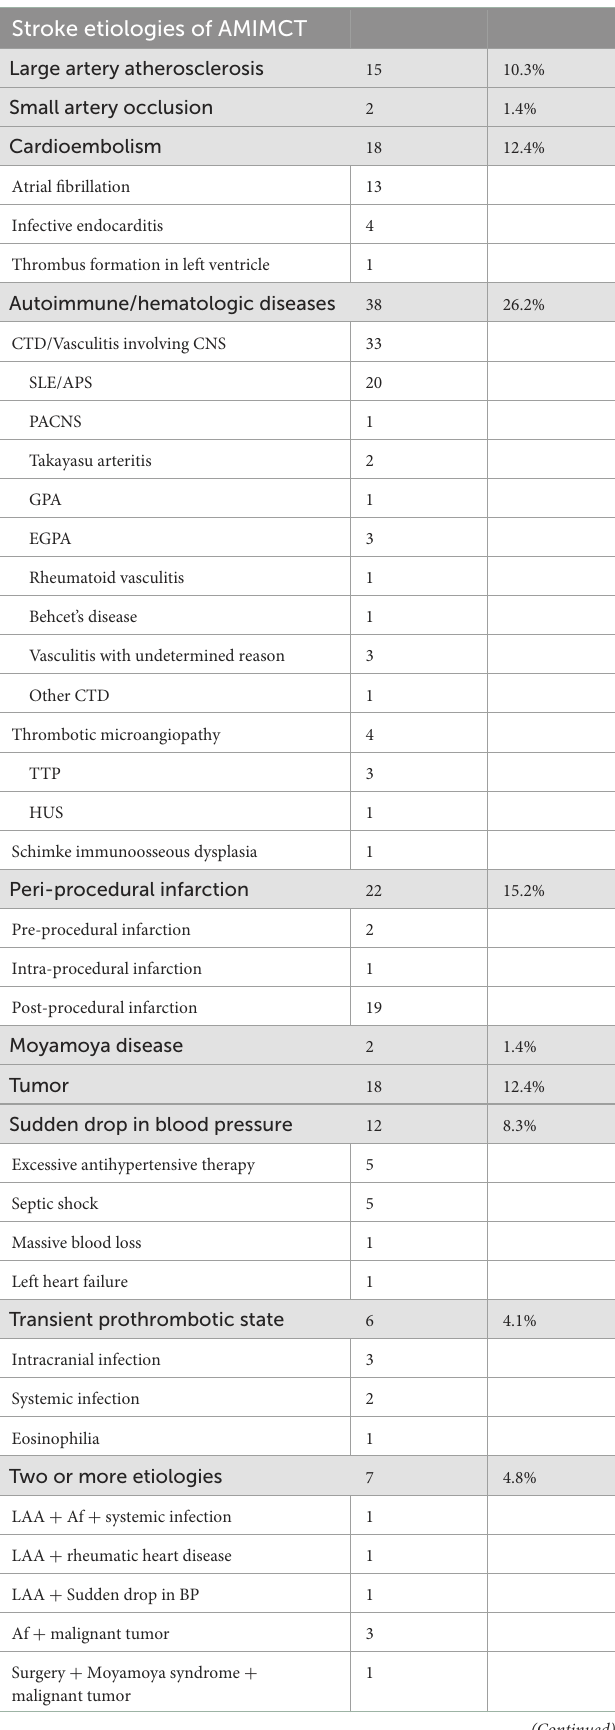
TABLE 2 Stroke etiologies of AMIMCT.